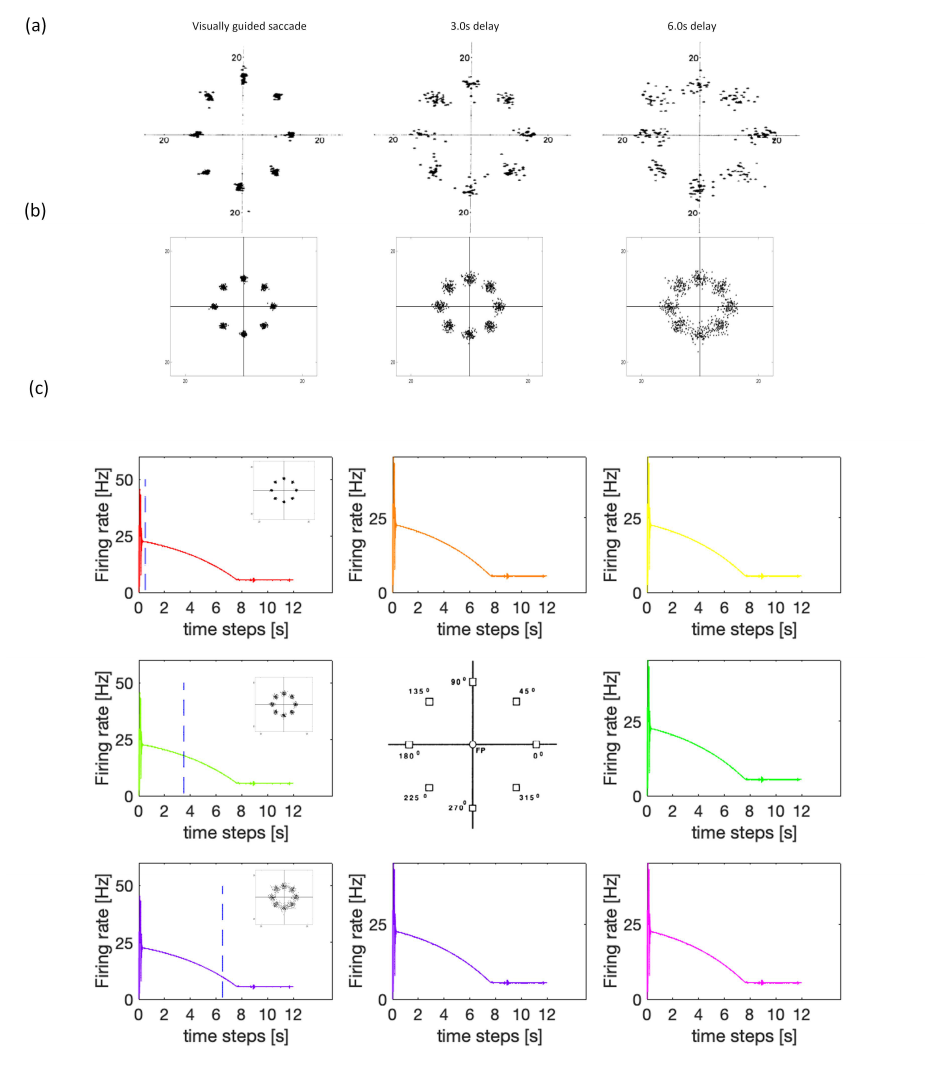
Figure 13. Oculomotor delayed response task experiment on a monkey and the stimulation results of SDN. ( a ) Experimental data from Funahashi et al. using a monkey’s oculomotor delayed-response task. ( b , c ) SDN simulation